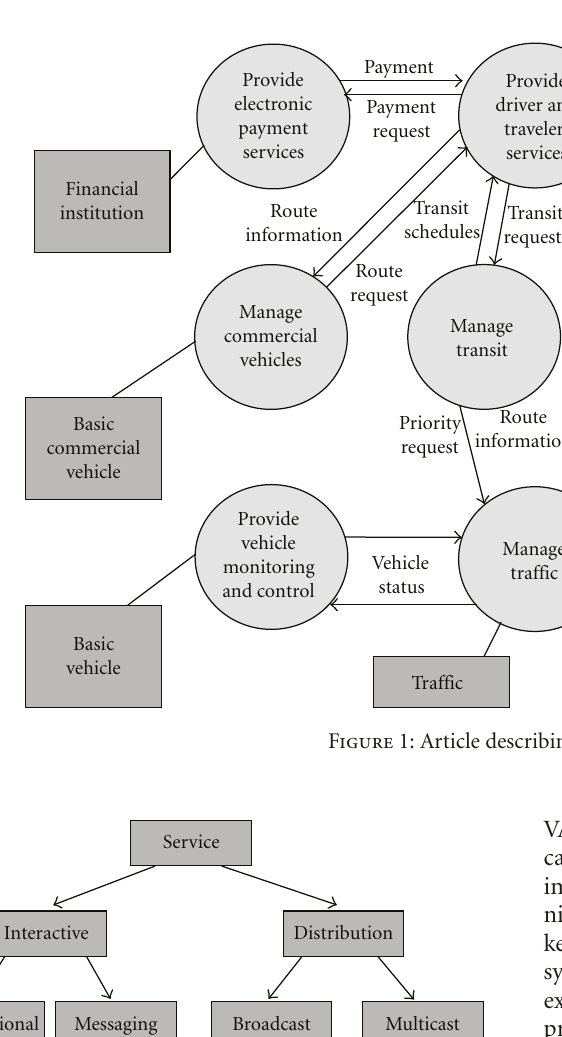
Figure 2: Communication services